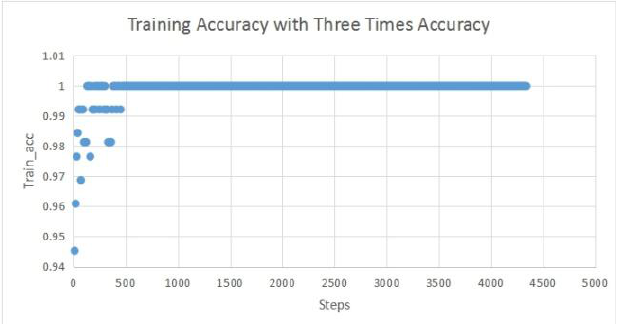
Figure 9. Train Accuracy of the overfitting model.